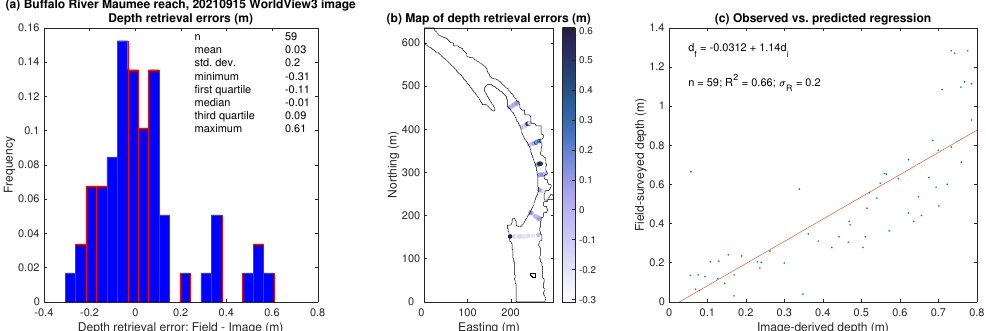
Figure 8. Accuracy assessment of depth estimates derived from the 15 September 2021, WorldView3 image of the Maumee reach. ( a ) Distribution of depth retrieval errors, defined as the field-measured depth minus the image-derived depth. ( b ) Map illustrating the spatial pattern of depth retrieval errors. ( c ) Observed (field-measured) vs. predicted (image-derived) depths regression.